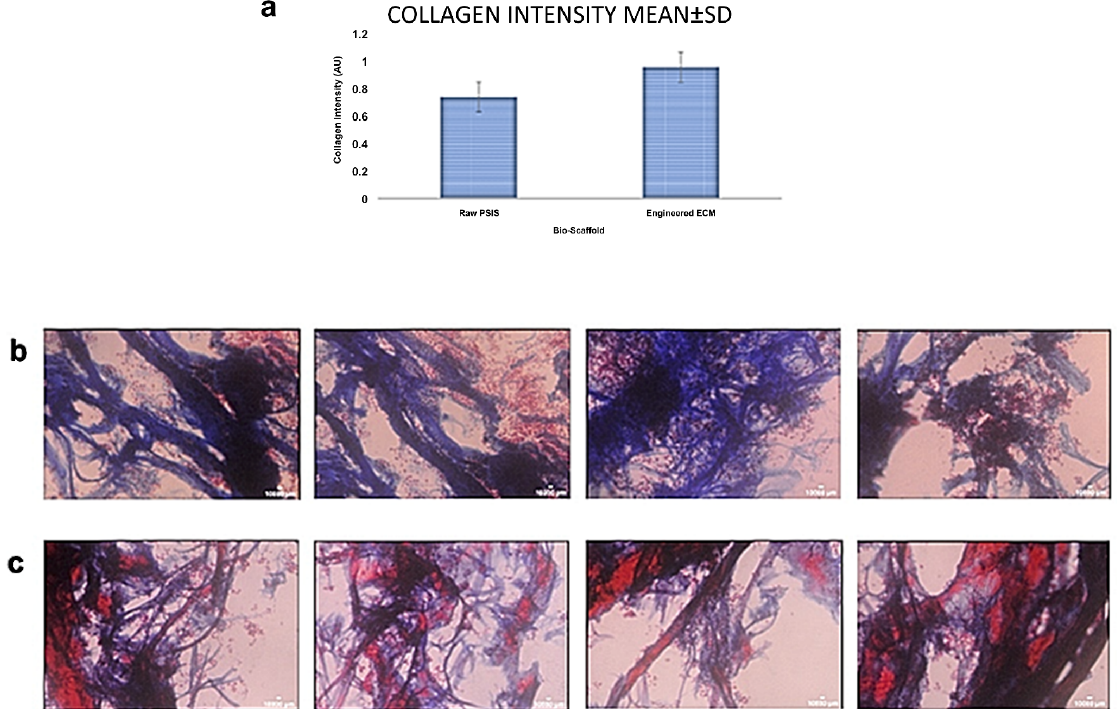
Figure 5. Rat VICs collagen secretion quantification and Masson’s Trichrome staining after seeding and subsequent culture for 8 days of static (rotisserie) culture and 7 days of oscillatory flow condi- tioning (TAWSS of 3.1 dynes/cm 2 and an OSI of 0.20; n = 4 specimens/group). ( a ) Average ± SD of collagen secretion by rat VICs seeded on the elastin-rich engineered ECM versus raw PSIS bio-scaf- folds. Masson’s Trichrome histological images of the de novo collagen secretion by rat VICs on the outer substrate surface (sectioned at 16 μ m from the outer surface) where the cells were seeded ( n = 4/group) on the: ( b ) engineered elastin-rich engineered ECM and ( c ) raw PSIS bio-scaffolds.